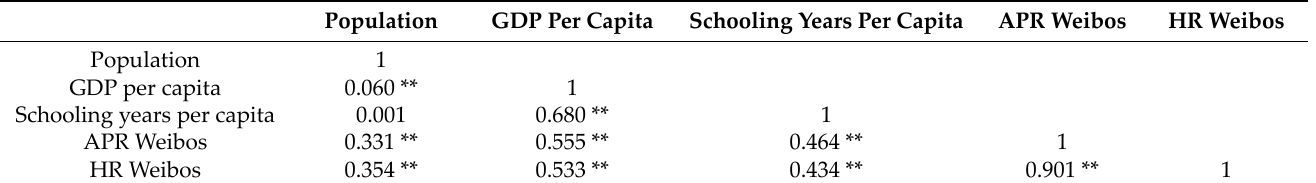
Table 4. Correlation between APR or HR Weibos and socioeconomic factors during 2017–2020 1